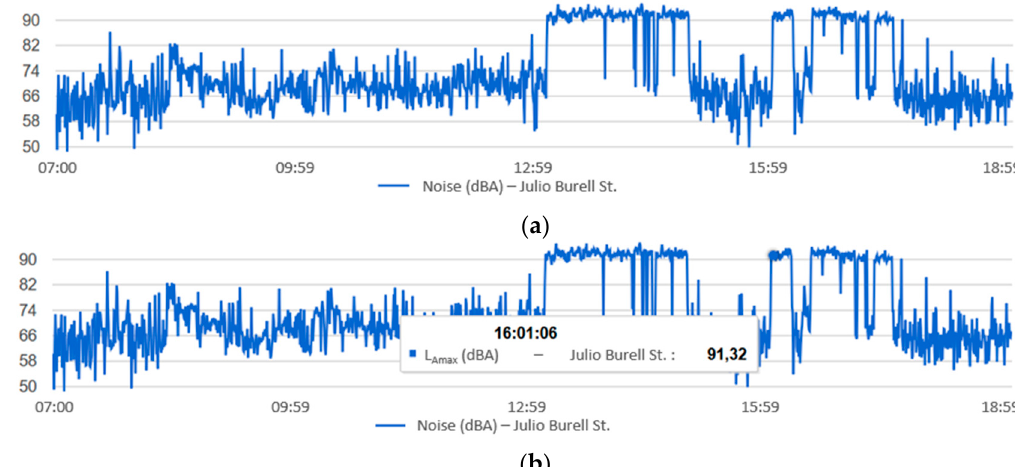
Figure A3. ( a ) The temporal evolution of the maximum noise at the Julio Burell St. location for the